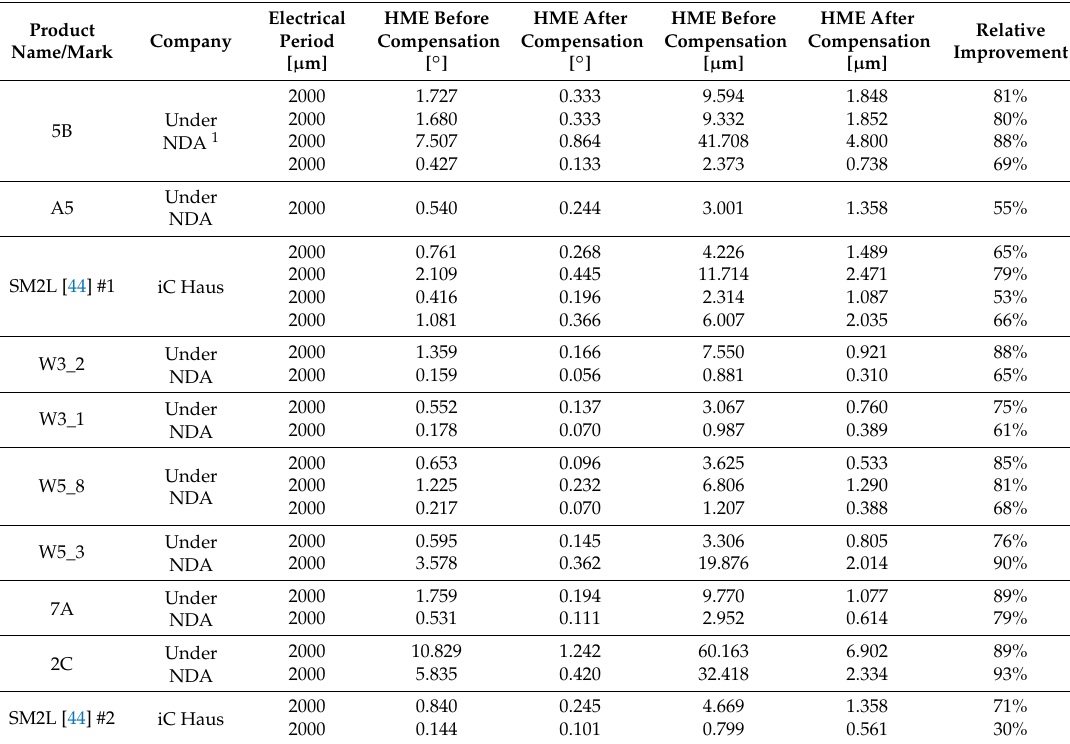
Table A1. The experimental data for AMR sensor samples.